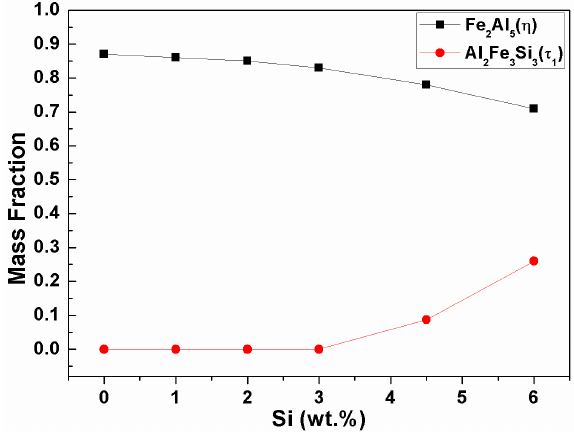
Coatings 2017 , 7 , 186